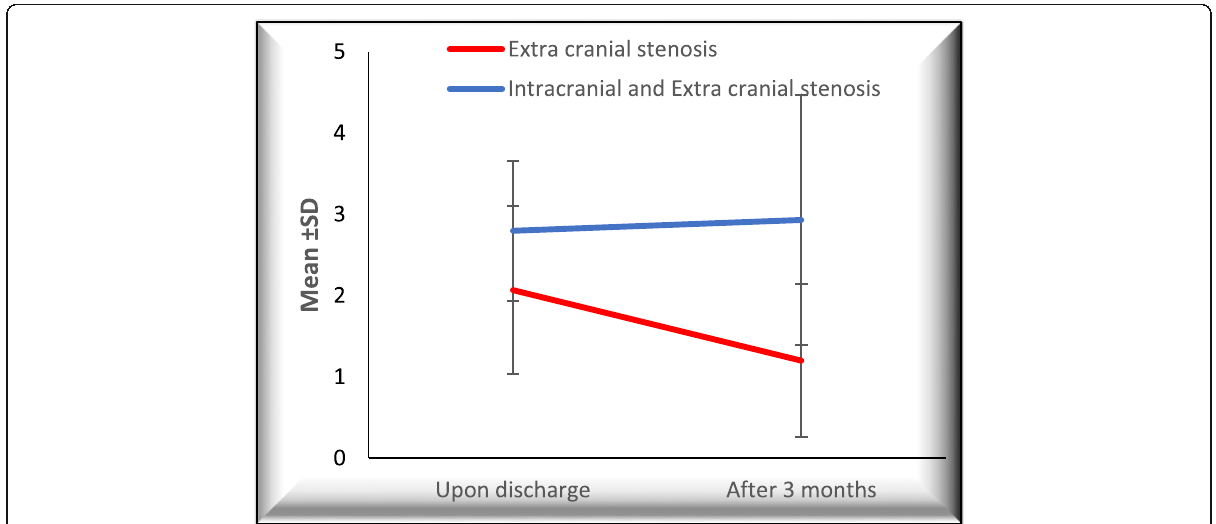
Fig. 2 Difference in mRS in both groups. Those 15 patients with extracranial stenosis showed less mRS both upon discharge with mean 2.067 ± 1.033 and after 3 months with mean 1.200 ± 0.941 than those 15 patients with both intracranial and extracranial stenosis both upon discharge with mean 2.800± 0.862 and after 3 months with mean 2.933 ± 1.534. Consequently, the first group with only extracranial stenosis showed